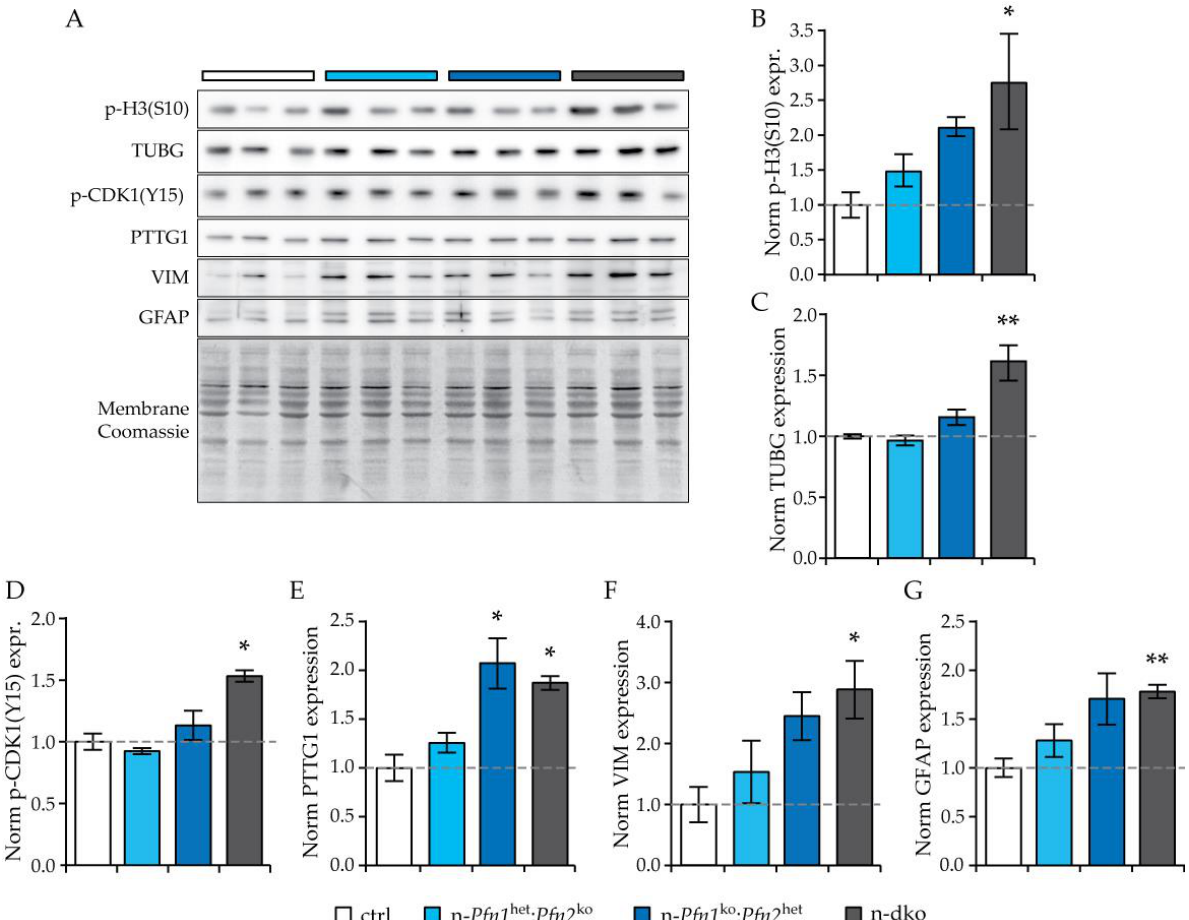
Figure 5. Markers of cell division G2 phase and of neural precursor cells are increased in n-dko embryos. ( A ) Western blots of the markers tested on E11.5 embryo head extracts of profilin mutants and controls. Total lane protein quantified by Coomassie staining of the membrane was used for calibration (a sample membrane is shown).Three extracts per genotype were analyzed, as indicated by the color bars. Histograms representing normalized quantification of ( B ) histone 3 Ser10 phosphorylation (p-H3(S10)), a marker of chromosome condensation, ( C ) γ -tubulin (TUBG), ( D ) CDK1 Tyr15 phosphorylation (p-CDK1(Y15)), and ( E ) PPTG1 (also known as securin) show increased expression in neural double profilin knockout (n-dko) embryos and an intermediate increase in the presence of a single Pfn2 allele (n- Pfn1 ko ; Pfn2 het ). The findings point to an arrest of NPCs cell division in the G2-phase. Histograms representing normalized quantification of the intermediate filament proteins ( F ) vimentin (VIM) and ( G ) glial fibrillary acidic protein (GFAP) show higher expression in n-dko embryos and an intermediate increase in n- Pfn1 ko ; Pfn2 het embryos, suggesting an accumulation of cells with NPC identity. For each marker, one-way ANOVA followed by Dunnett’s post hoc test was applied, to compare to ctrl levels; n = 3 per genotype; * p ≤ 0.05, ** p ≤ 0.01.